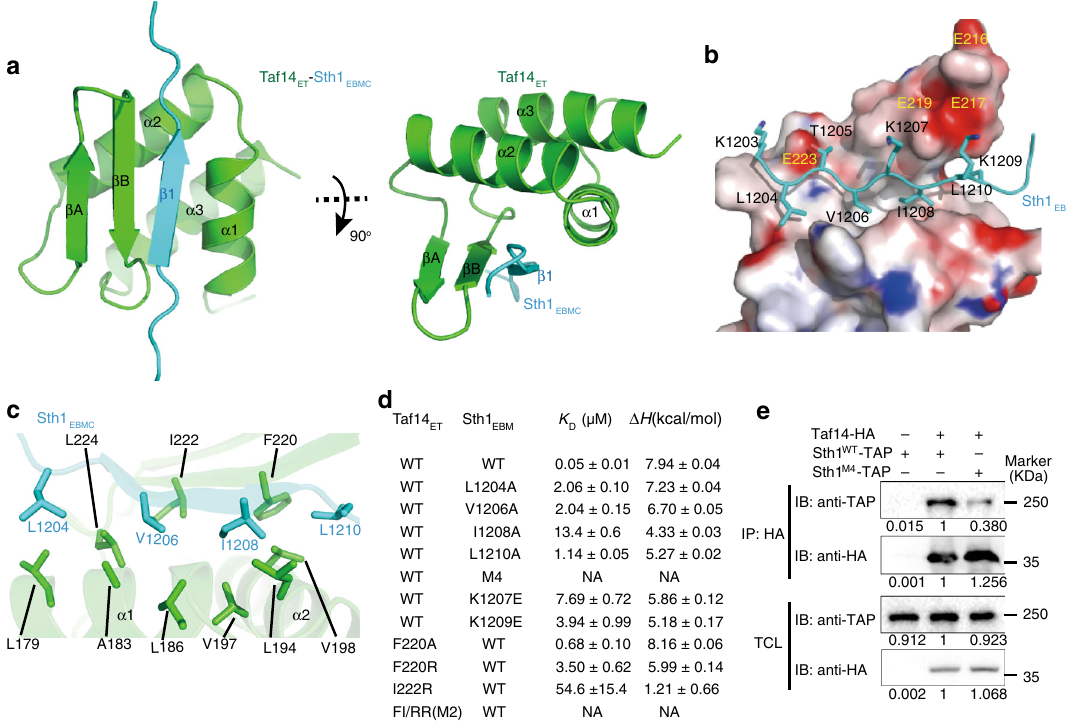
Fig. 2 Structure of the Taf14 ET – Sth1 EBM complex determined by NMR. a Two orthogonal views of the Taf14 ET – Sth1 EBM complex. Taf14 ET is colored in green and Sth1 EBM is colored in cyan. b The interface between Taf14 ET and Sth1 EBM . Sth1 ET is shown as a surface model colored according to its electrostatic potential (positive potential: blue; negative potential, red). The residues through which Sth1 EBM interacts with the Taf14 ET are presented as ball-and-stick models. The four acidic residues of Taf14 ET are labeled. c Details of hydrophobic interactions. The critical residues are presented as ball-and-stick models. d ITC results showing that the targeted mutations decreased the af fi nity of the interaction between Taf14 ET and Sth1 EBM . M4 stands for the Sth1 L1204A/V1206A/I1208A/L1210A mutation. e Co-immunoprecipitation using an HA antibody showed that Sth1 M4 mutation weakened the interaction with Taf14. Taf14 was tagged with HA; Sth1 was tagged with TAP. TCL total cell lysate, IP immune-precipitation, IB immune-blot. Source data are provided as a Source Data fi Taf14 – Sth1 interaction. The taf14 Δ and taf14 M ( taf14 M is taf14